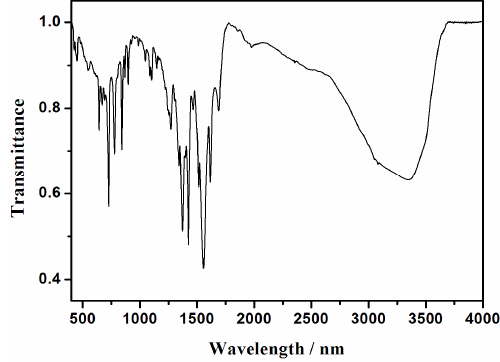
Figure 5. The IR (Infrared) spectra of the complex 1.